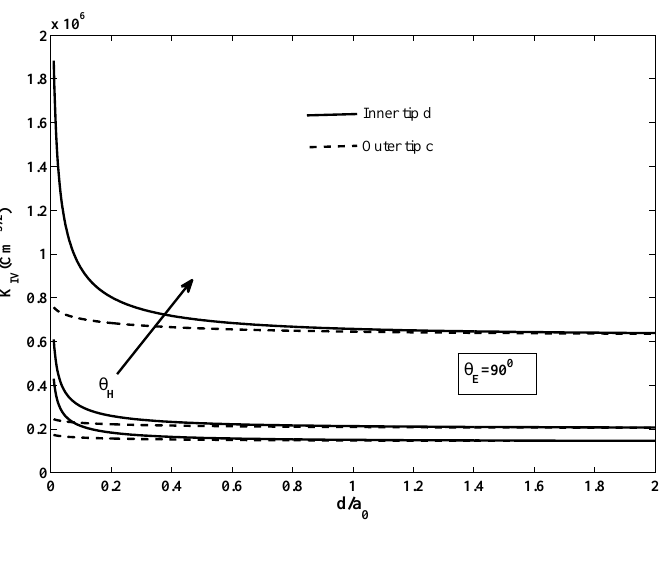
Fig. 16 EDIF versus inter-crack distance for different magnetic poling with fixed electric poling